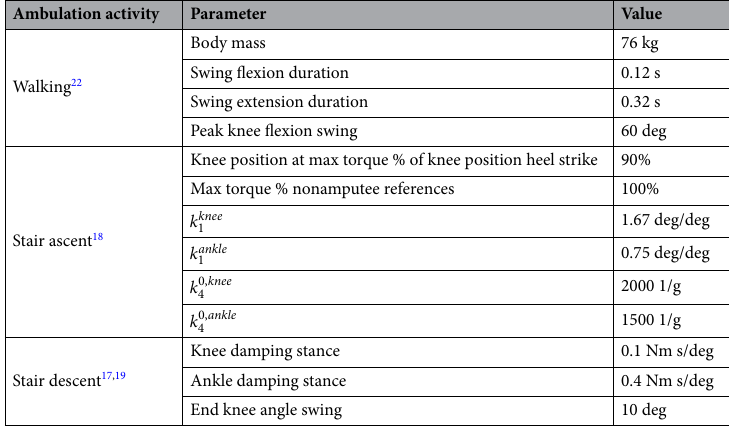
Table 4. Ambulation activity parameters tuned to participant